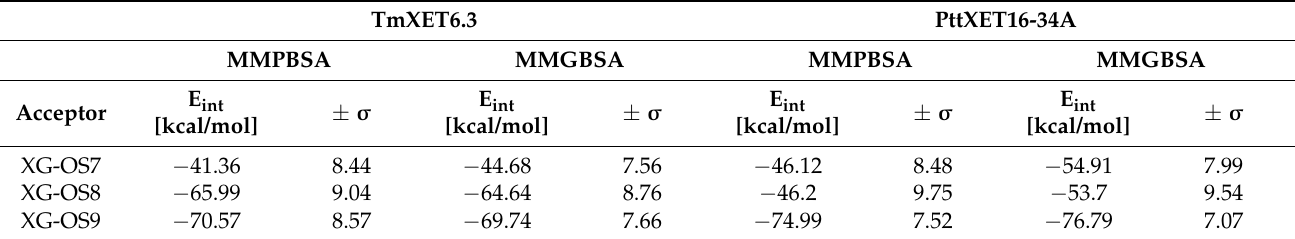
Table 3. Binding free energy values of TmXET6.3 and PttXET16A in complex with XG-OS acceptors based on MM(PB/GB)SA calculations. Values were obtained from 800–1000 ns time intervals of MD